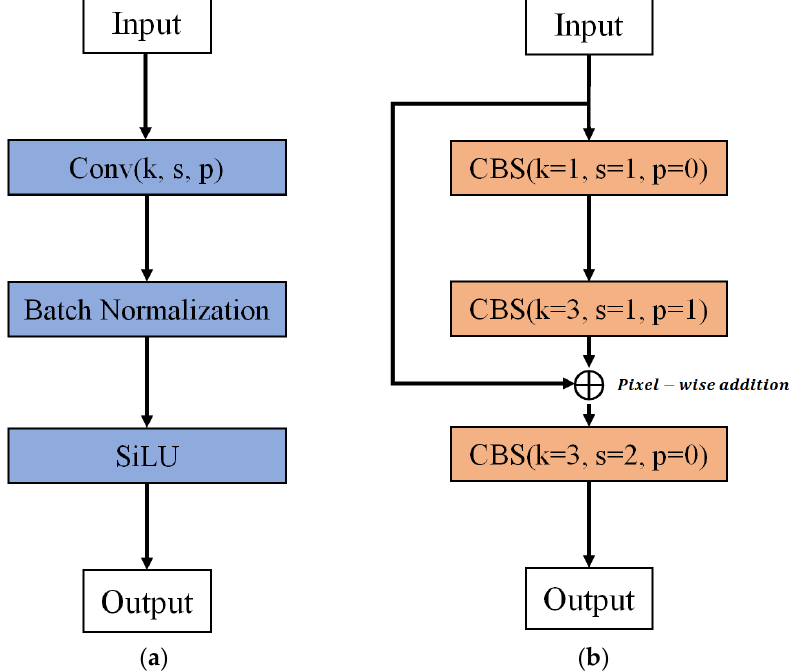
Figure 2. Sub-layers of ( a ) CBS layer and ( b ) Down-sampling layer.